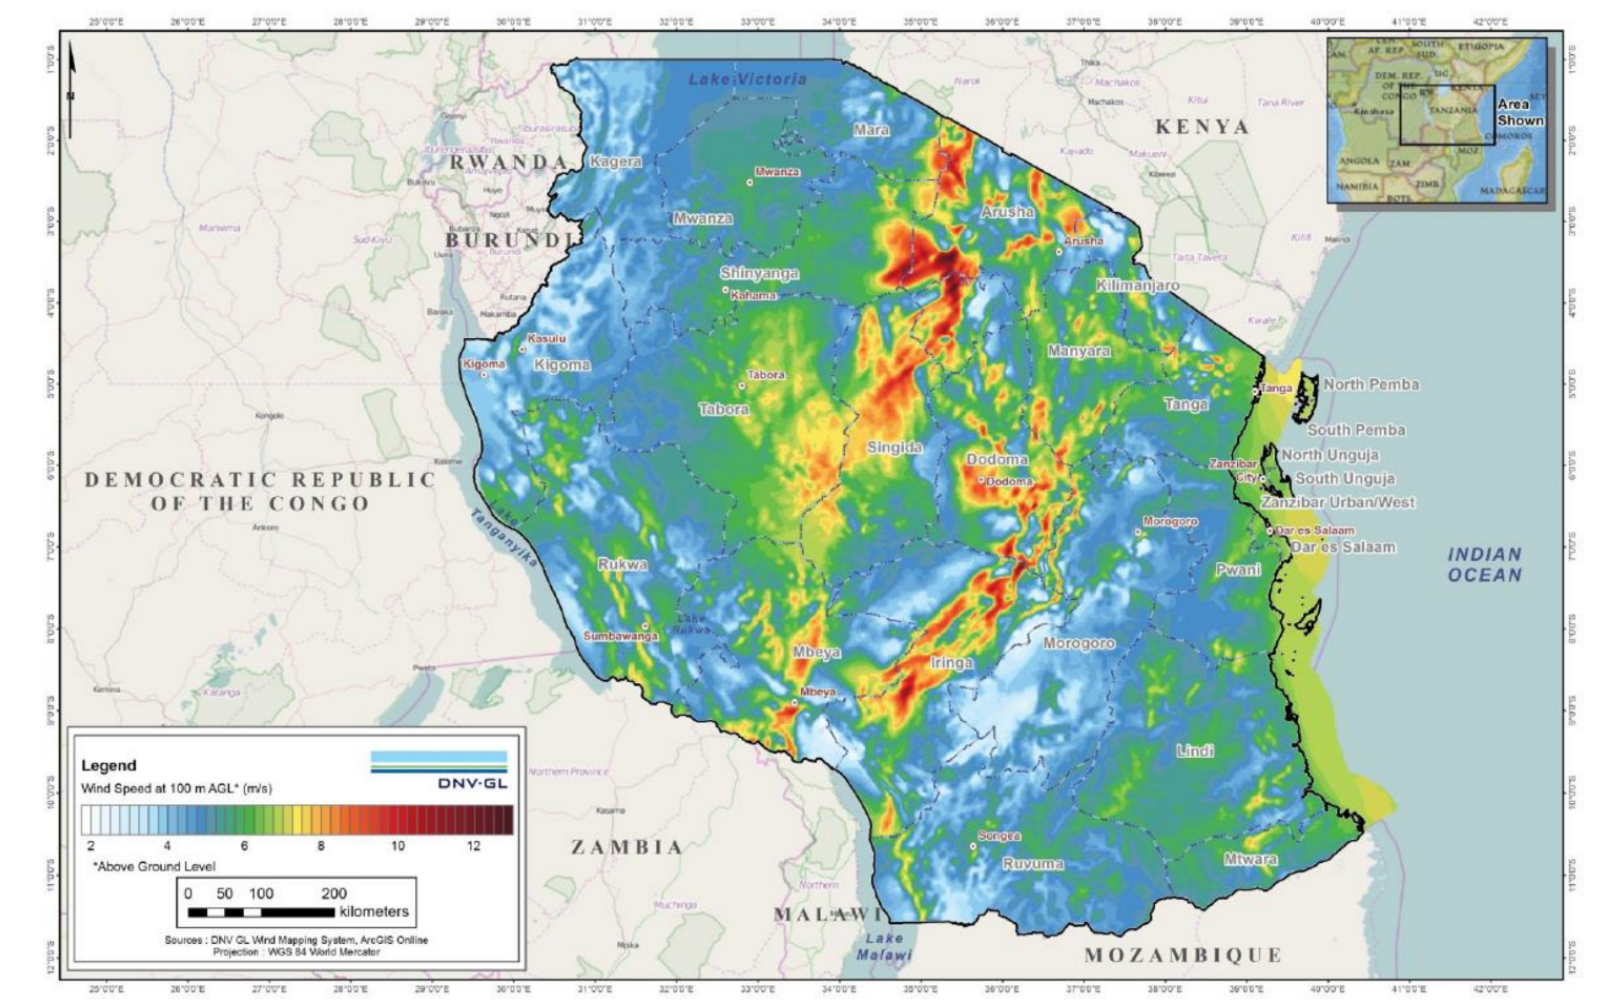
Figure 3. Wind Potential for various areas of Tanzania